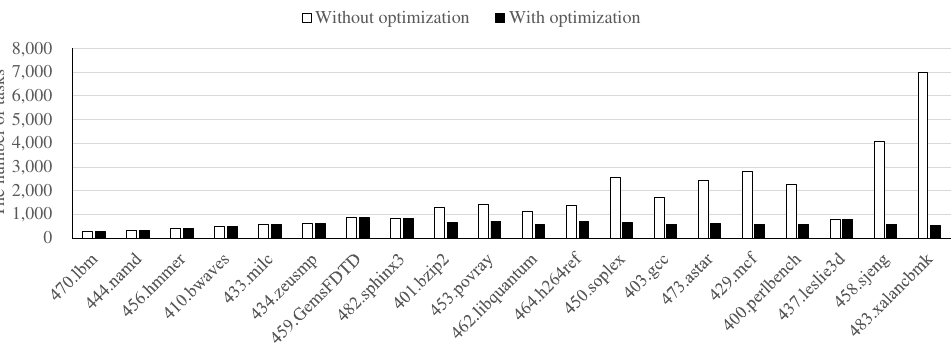
Figure 13. Reduction in the number of tasks using task management optimization strategy on 256 cores.